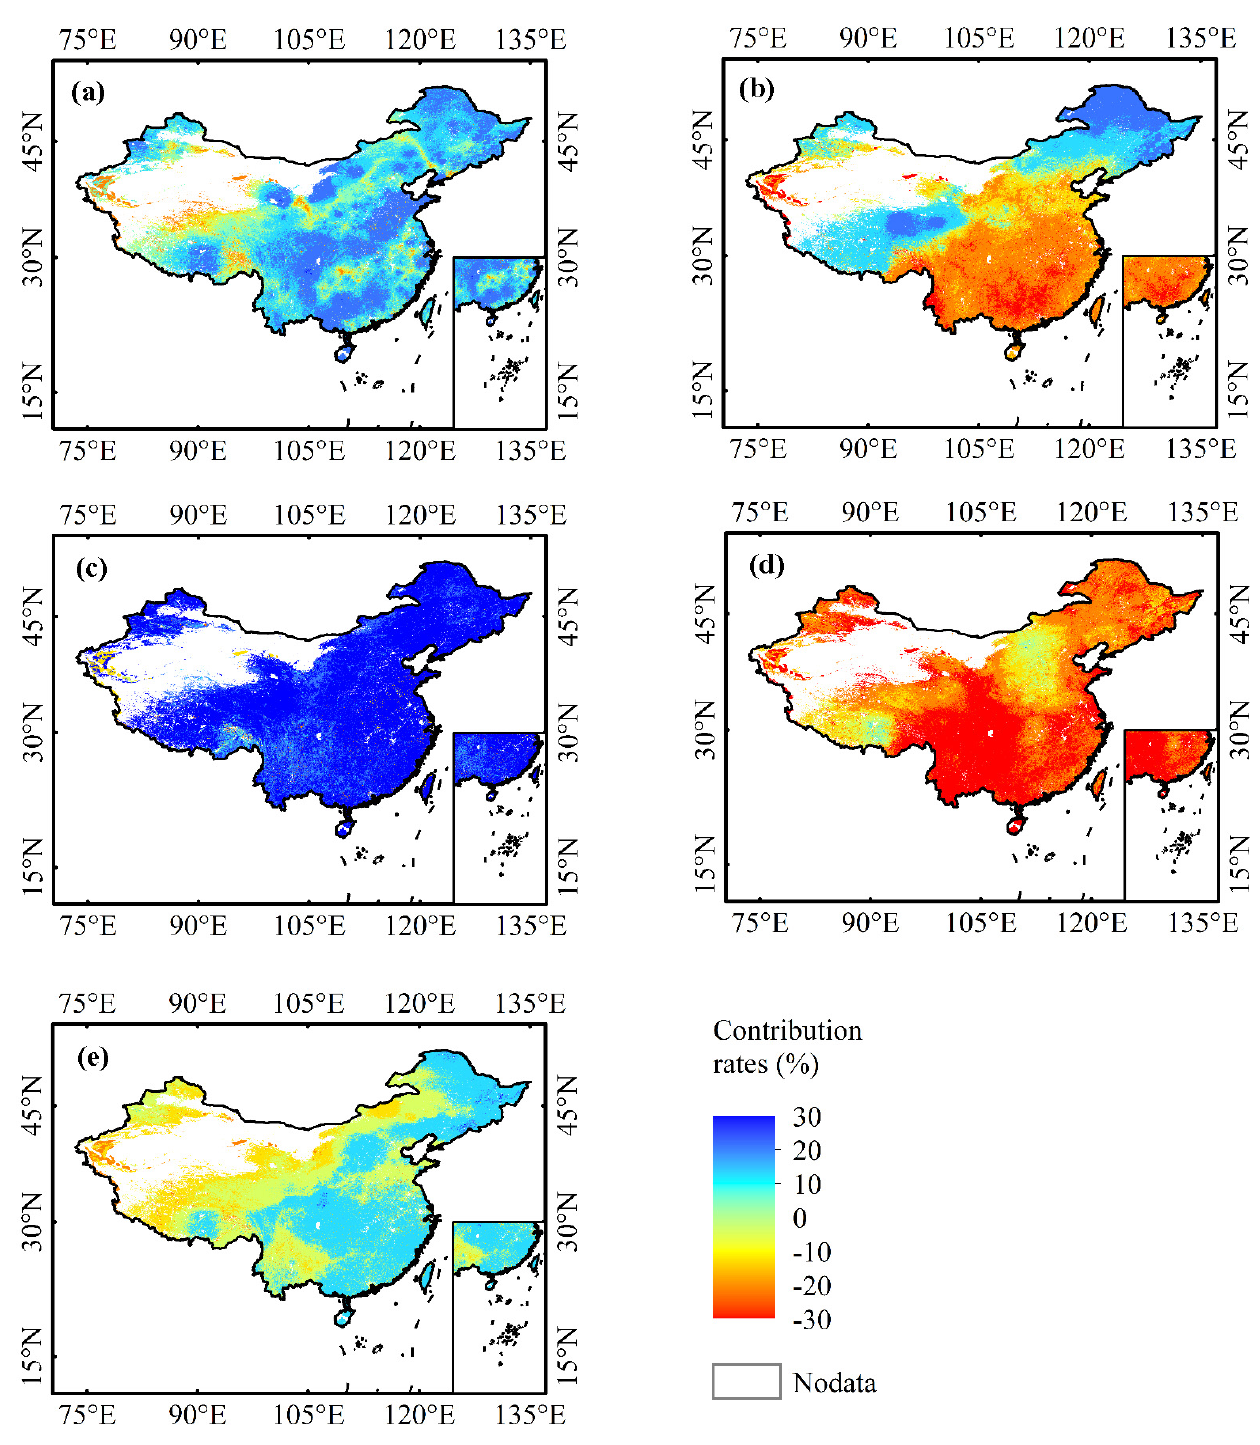
Figure 9. The spatial distribution of the contribution rates of climatic factors to the interannual change of Ei during 2001 − 2020. ( a ) Wind speed; ( b ) temperature; ( c ) precipitation; ( d ) relative humidity; ( e ) sunshine duration.